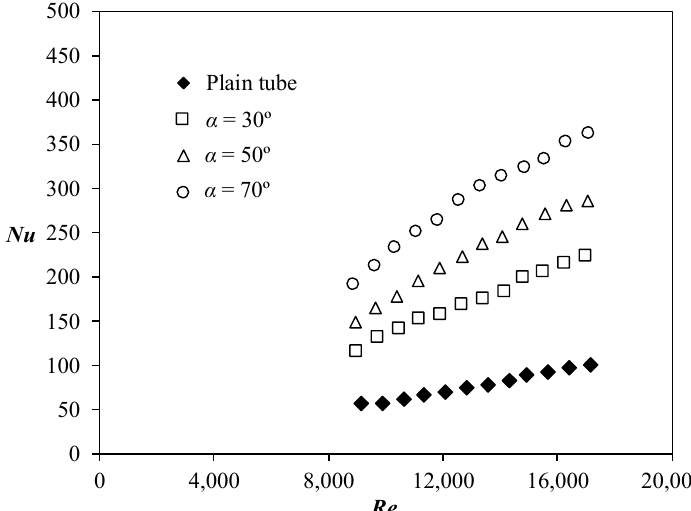
Figure 5. Nusselt number for various attack angles.